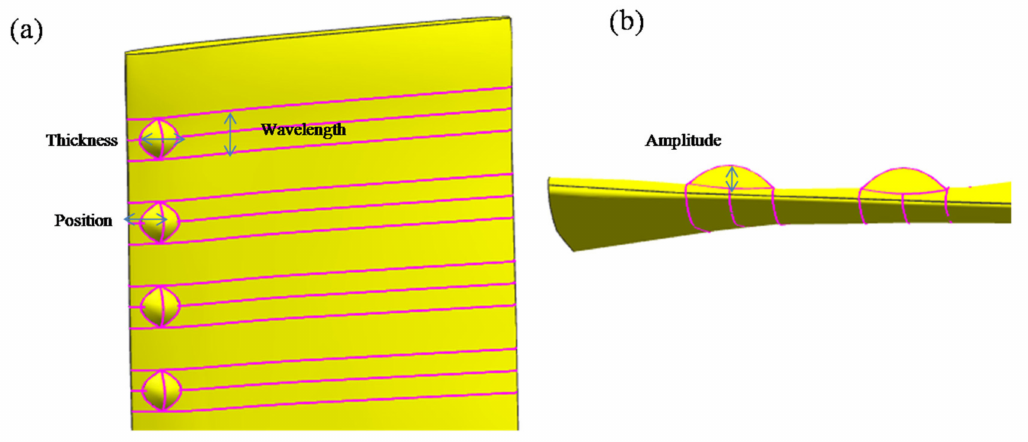
Figure 2. Blade with tubercles: ( a ) streamwise view and ( b ) spanwise